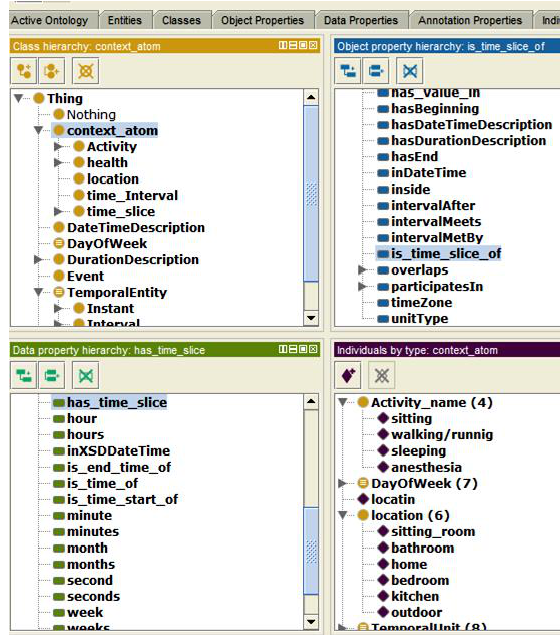
Figure7. Classes and relations in Chronos